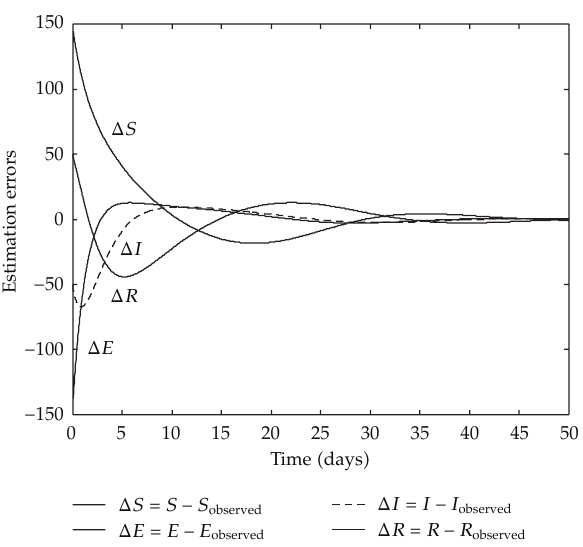
Figure 1: Observation error in the vaccination-free case and all the parameters